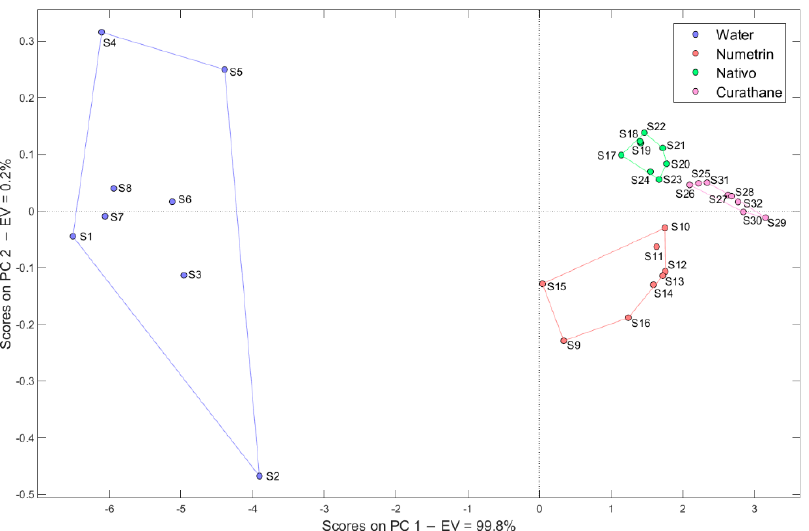
Figure 3. PCA plot using the carbon electrode (C110) for the discrimination of Numetrin, Nativo, and Curathane pesticides against distilled water samples.